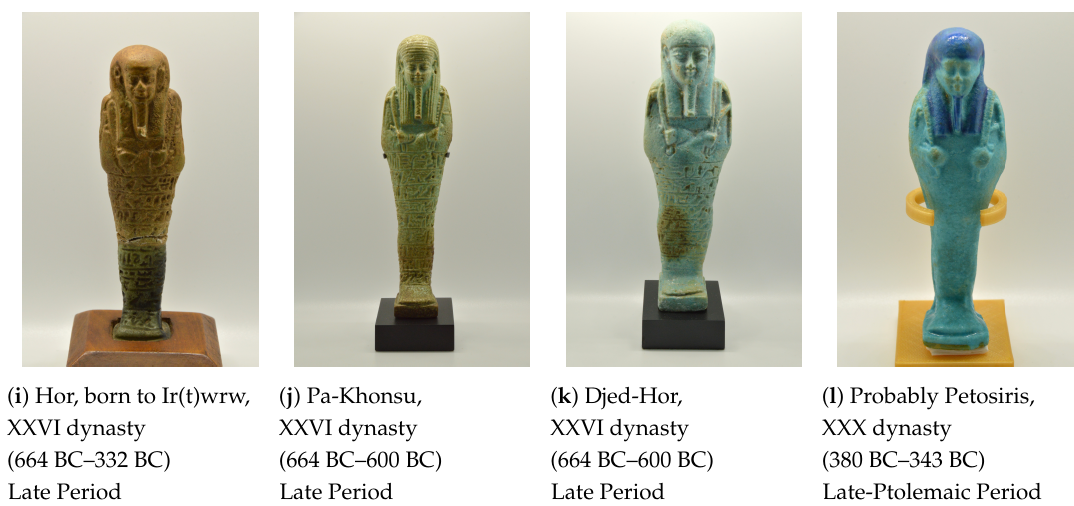
Figure 3. Different styles of shabtis from different periods: New Kingdom (1550 BC–1069 BC), Third Intermediate Period (TIP) (1069 BC–664 BC) and Late Period (664 BC–332 BC). Private